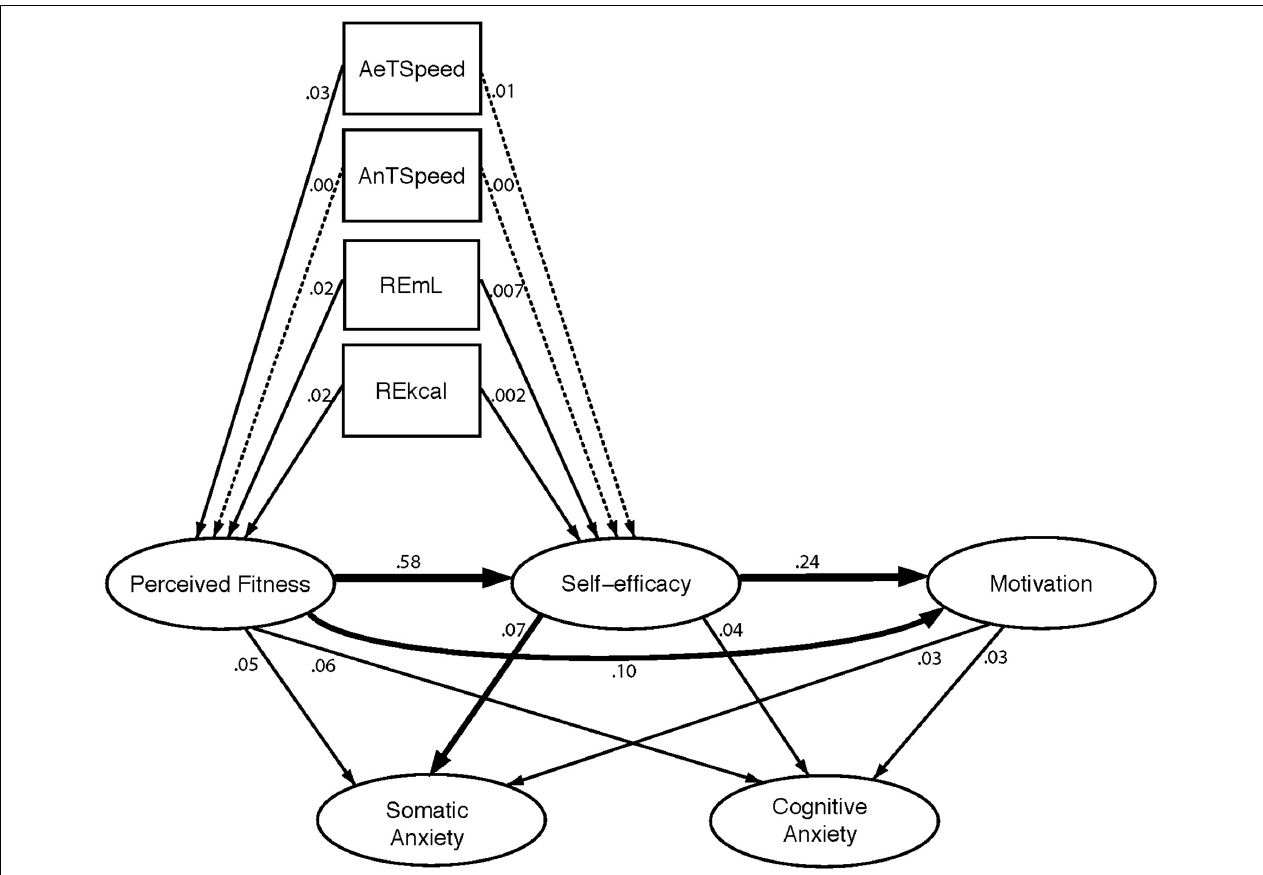
FIGURE 3 | Summary of longitudinal R 2 values found in the study. Numbers represent the effect ( R 2 ) of the predictor adjusted for participant and multiple measurement effects using separate linear mixed effects models for each association tested. Arrows represent the direction of the prediction. Thinness of the arrows represents the magnitude of the effect size ( f 2